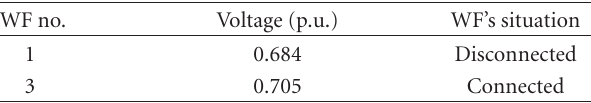
Table 5: Results obtained with proposed controller in the case of 2WFs. WF no. Voltage (p.u.) WF’s situation 1.071 Connected 1.062 Connected